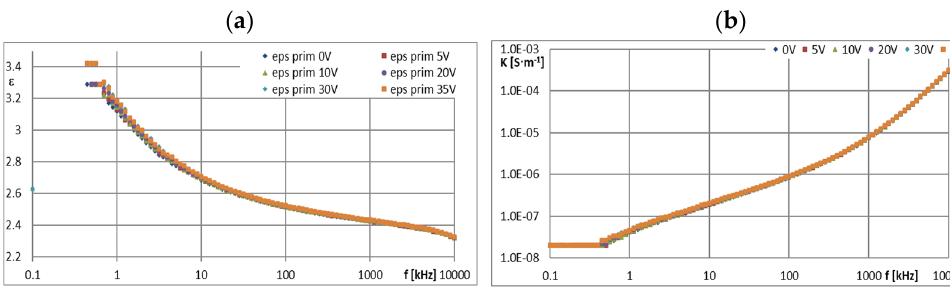
Figure 11. Characteristics: ( a ) ε = f( f ) and ( b ) κ = f( f ) for LID 3354S at different values of U.